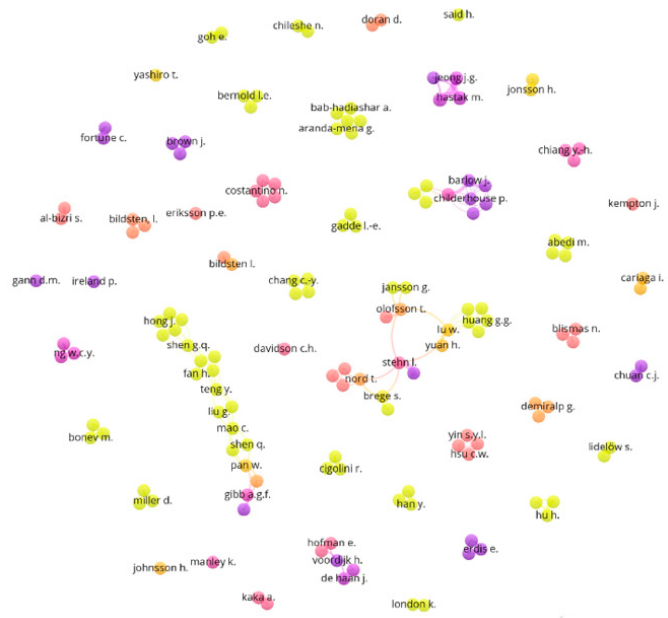
Figure 6. A collaborative network of researchers .